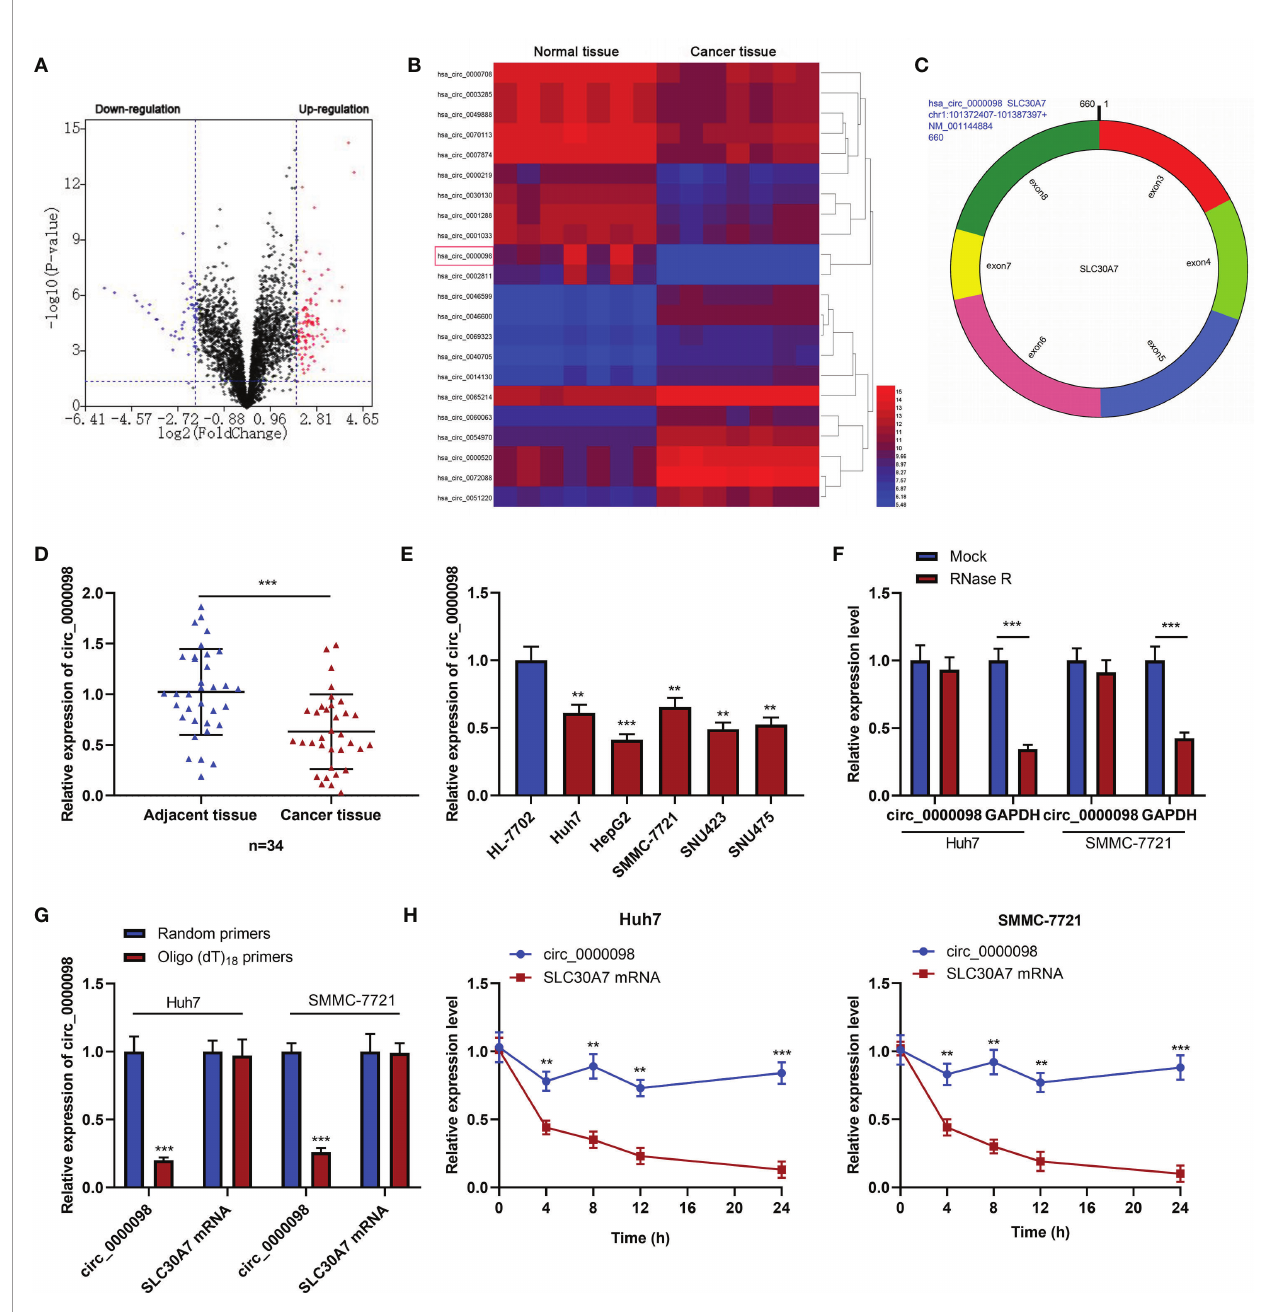
FIGURE 1 | The expression of circ_0000098 was signi fi cantly down-regulated in HCC tissues and cells. (A) Volcano plot was used to show the expression changes of circRNAs in HCC tissues and normal tissues adjacent to cancer. CircRNAs whose expressions were signi fi cantly increased were marked in red, and those whose expressions were signi fi cantly decreased were marked in blue. (B) Heatmap showed differentially expressed circRNAs in HCC tissues relative to adjacent normal tissues. Red and blue colors indicate high-expression and low-expression, respectively. (C) The schematic diagram of circ_0000098 formation from SLC30A7 exons. (D) The expression of circ_0000098 in HCC tissues and adjacent tissues was detected by qRT-PCR. (E) qRT-PCR was used to detect the expression of circ_0000098 in HCC cells and HL-7702 cells. (F) Circ_0000098 and GAPDH mRNA expressions were detected by qRT-PCR after RNase R treatment, so as to determine the circular characteristics of circ_0000098. (G) The expressions of circ_0000098 and linear SLC30A7 mRNA were detected by qRT-PCR after total RNA was reversely transcribed using random primers or oligo (dt) 18 primers. (H) The expressions of circ_0000098 and liner SLC30A7 mRNA were detected in Huh7 and SMMC-7721 cells by qRT-PCR after treatment with actinomycin (D) ** P < 0.01 and *** P <